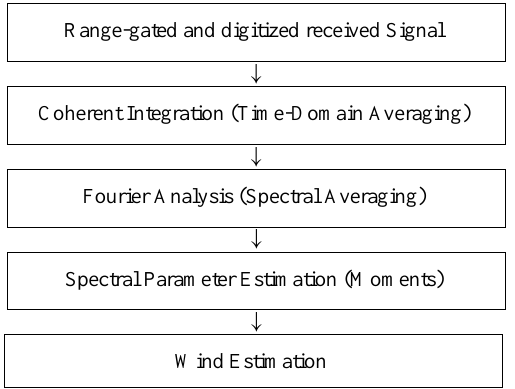
Fig. 1. The figure shows the flow diagram of ’classical’ digital sig- nal